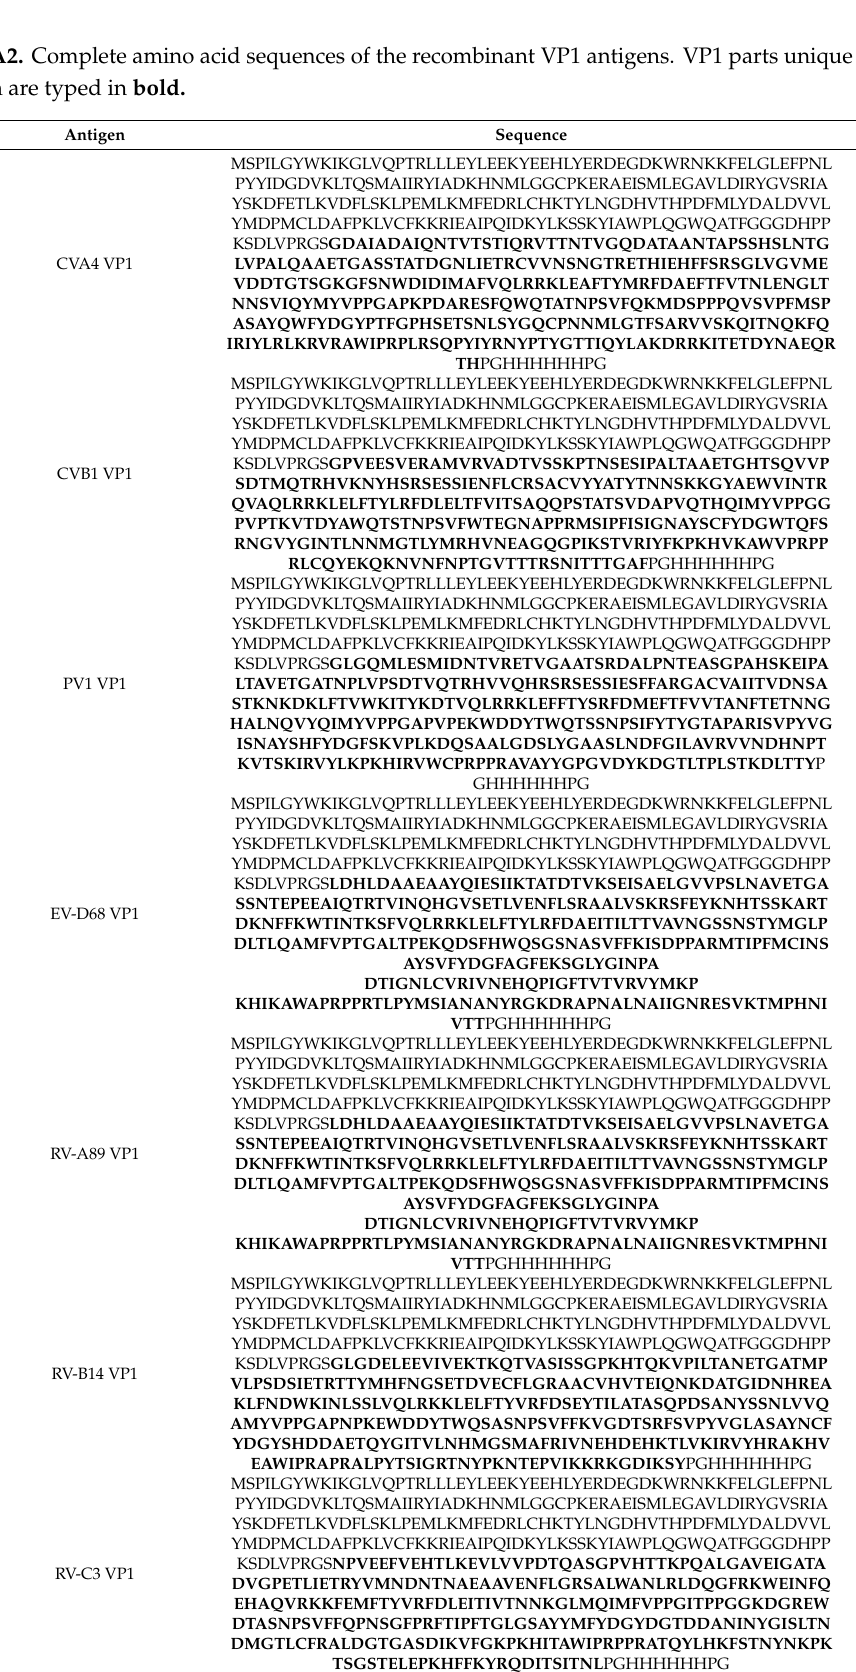
Table A2. Complete amino acid sequences of the recombinant VP1 antigens. VP1 parts unique to each antigen are typed in